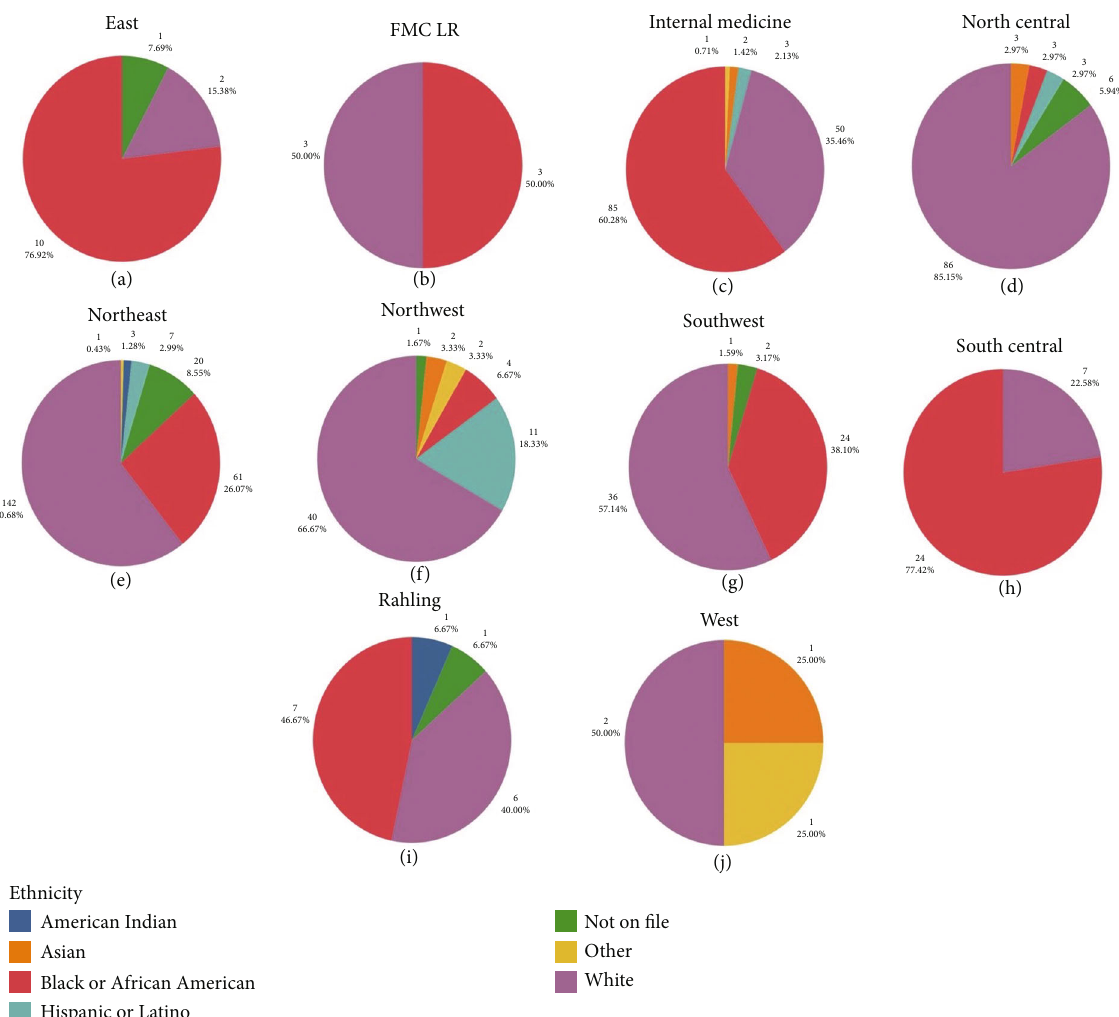
Figure 3: Graphs showing the distribution of race at each of the regional programs participating in the teleretina screening program: (a) East, (b) FMC LR, (c) Internal medicine, (d) North Central, (e) Northeast, (f) Northwest, (g) Southwest, (h) South Central, (i)Rahling, and (j) West. FMC LR: Family Medical Center Little